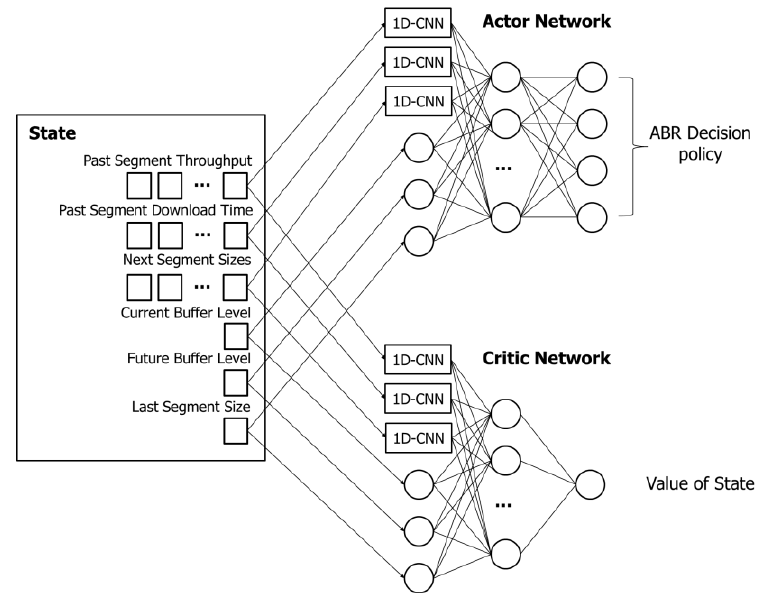
Figure 3. Architecture of actor network and critic network.